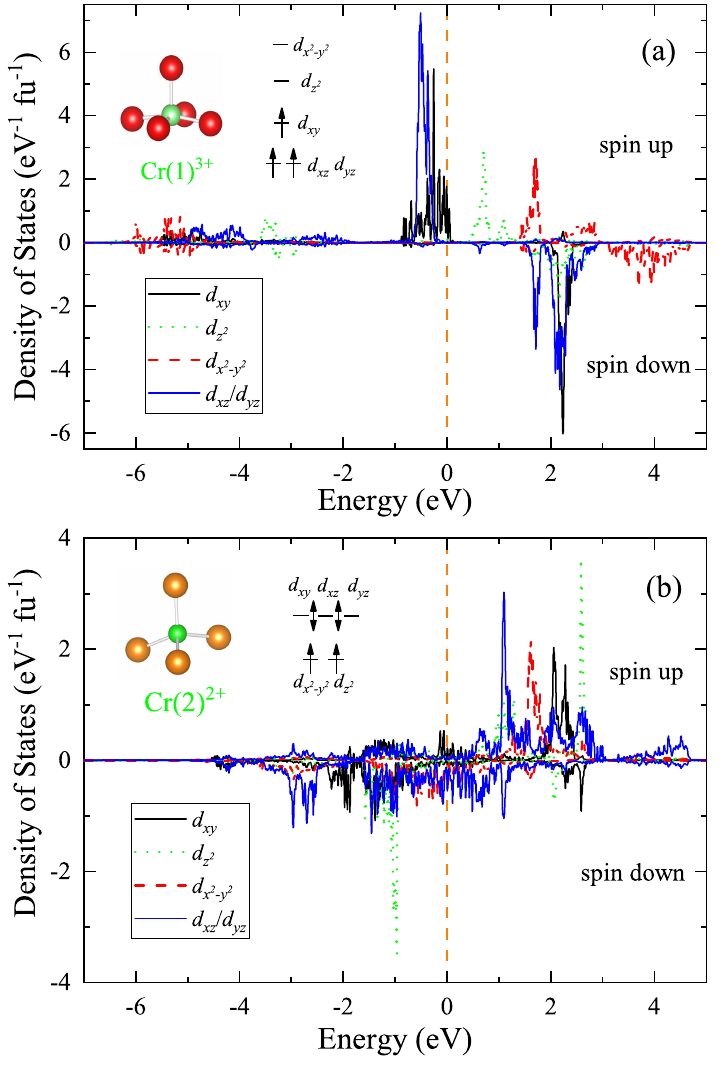
Figure 9. Projected density of states of 3 d orbitals of the Cr(1) at (1/4, 1/4, 0.3116) ( a ) and Cr(2) at (1/4, 3/4, 0) ( b ) sites in the C-type antiferromagnetic state of Sr 2 Cr 2 AsO 3 . The insets show the coordinations of Cr(1) and Cr(2) and their corresponding crystalline field